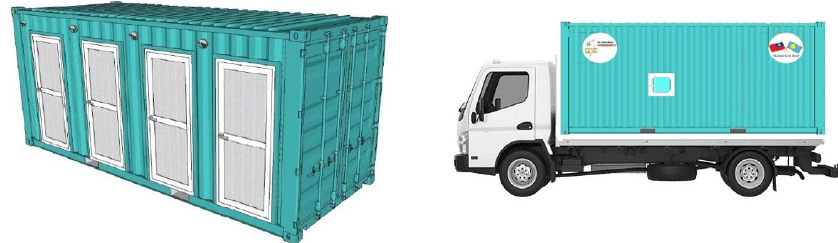
Figure 2. Simple schematic of the appearance of a mobile medical station. 2.2. Cut off the Transmission Routes: Positive and Negative Pressure System